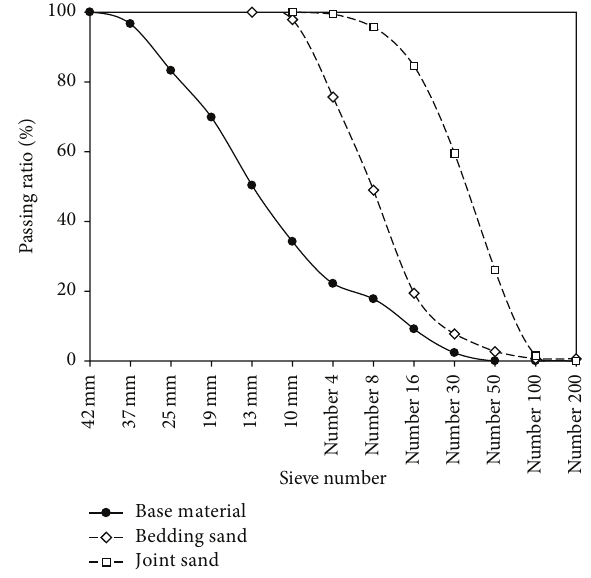
Figure 2: Passing ratios of sand and base